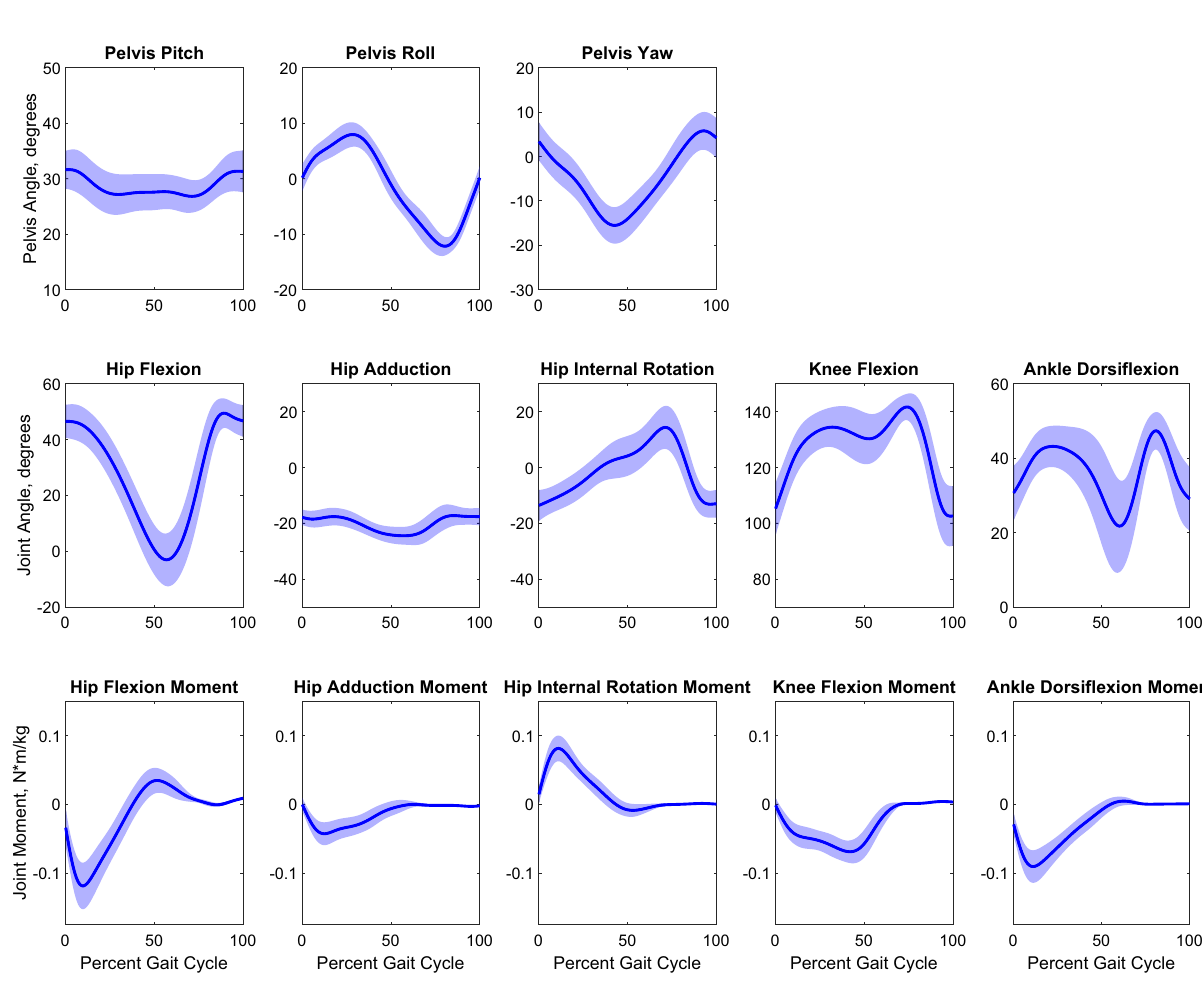
Figure 2. Kinematic (joint angles, top 2 rows) and kinetic (joint moments, bottom row) curves for healthy female Lewis rats. Curves are shown as mean + /− 1STD for pelvic rotation, hip flexion angle/moment, hip adduction angle/moment, hip internal rotation angle/moment, knee flexion angle/moment, and ankle dorsiflexion